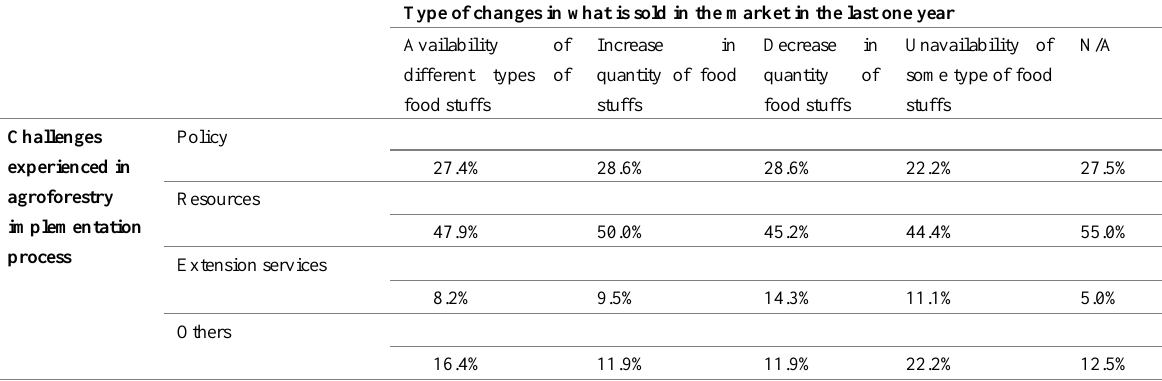
Table 6: Influence of Challenges experienced in agroforestry implementation process on changes in food sold in the market in the